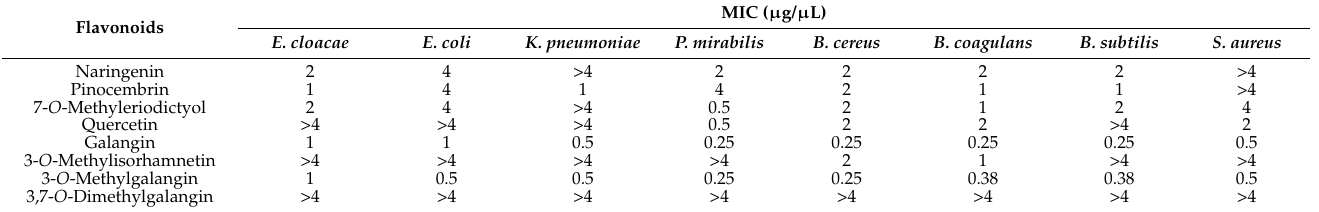
Table 5. Antibacterial activity of flavanones and flavones against Gram-positive and Gram- negative bacteria.